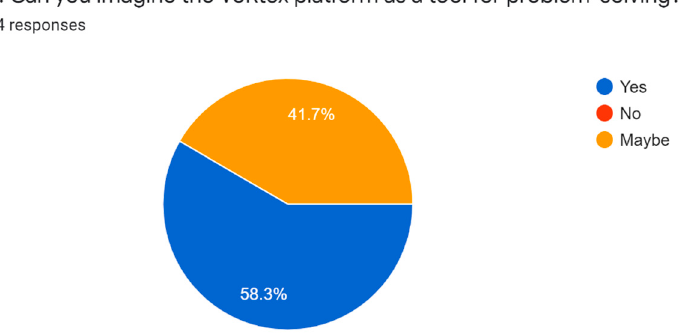
Figure 16. VoRtex test results from Google Forms report. Problem-solving activities.